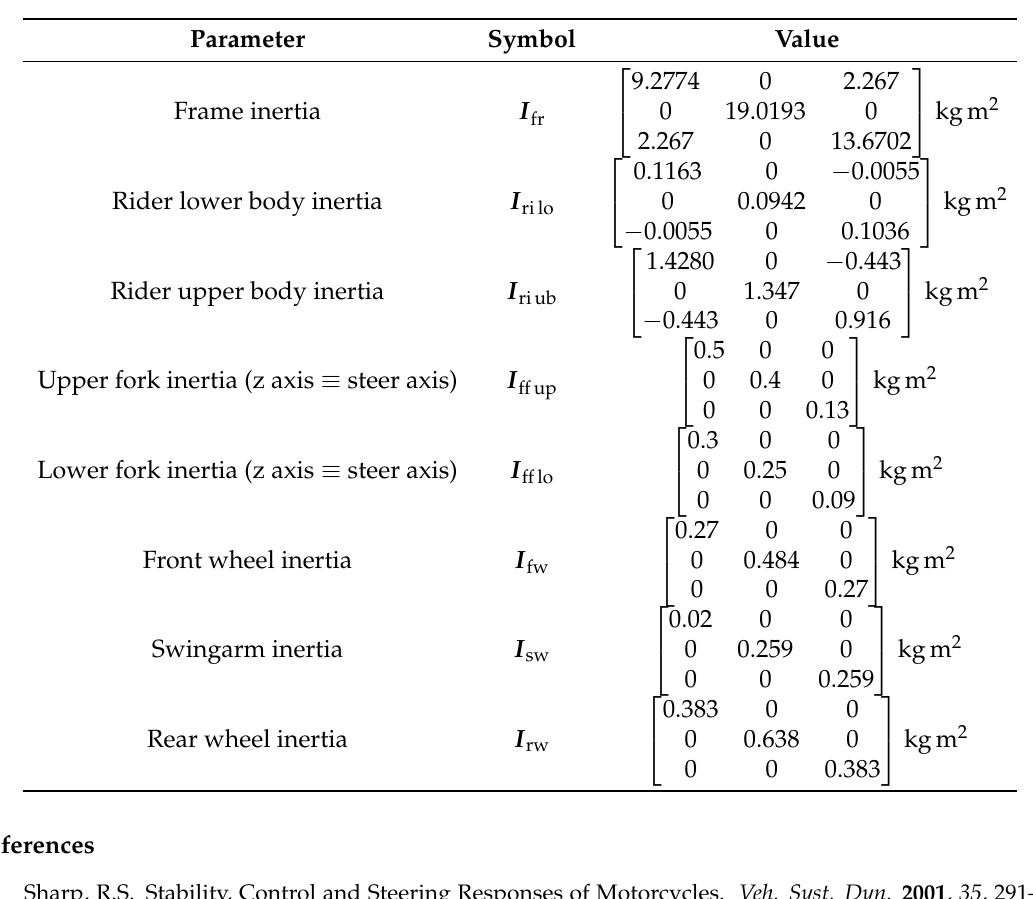
Table A7. Inertia